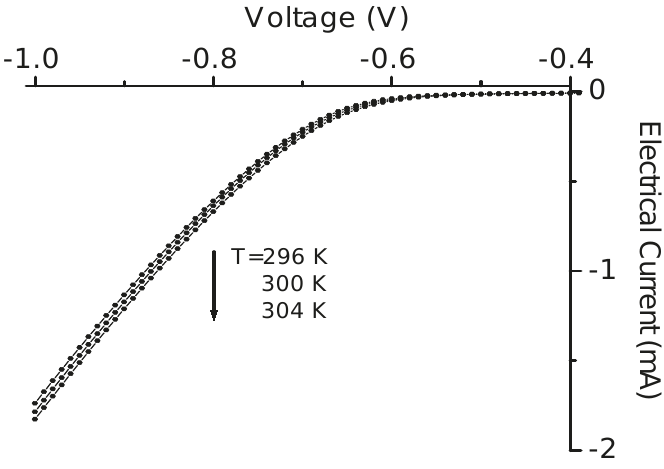
Figure 4. The variation of electrical currents as a function of applied voltages at three temperatures (T = 296 K, 300 K, and 304 K) for a fabricated silicon diode temperature sensor.